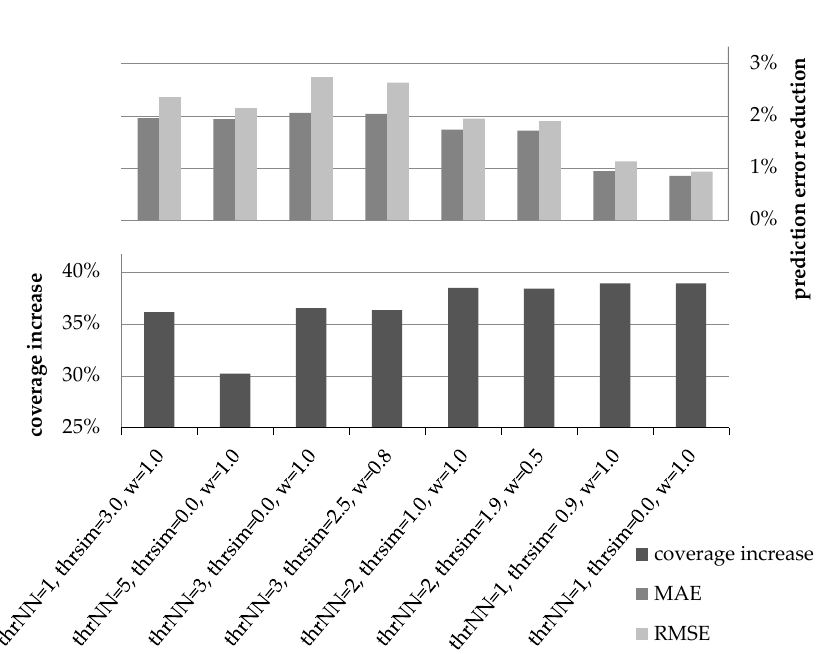
Figure 1. Prediction error reduction and coverage increase under different parameter value combinations, when using the PCC as the similarity metric.